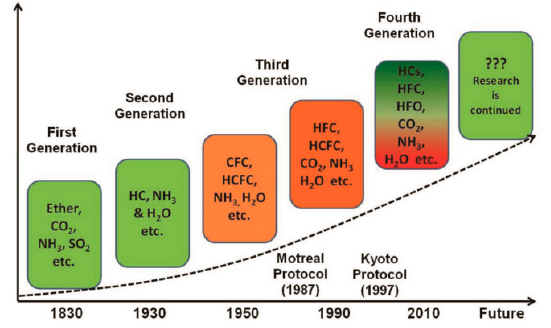
Figure 3. Evolution of refrigerants [7].